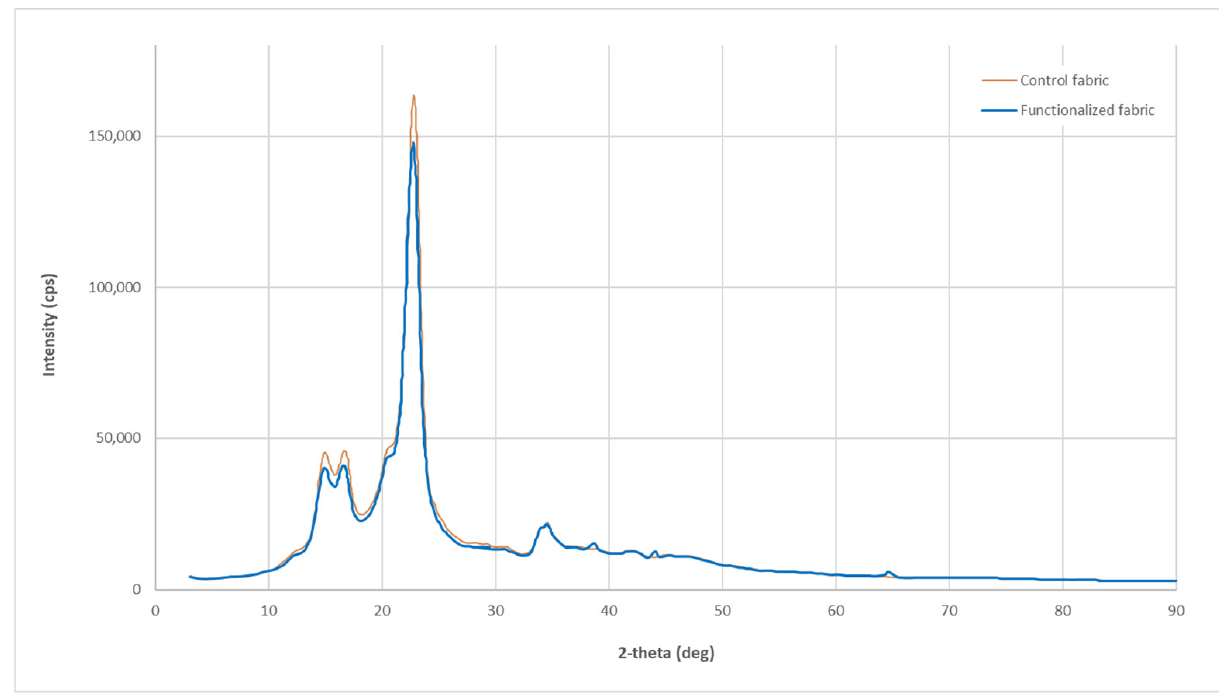
Figure 3. XRD pattern of control fabric and functionalized fabric with AgNPs-CMC nanocomposite.